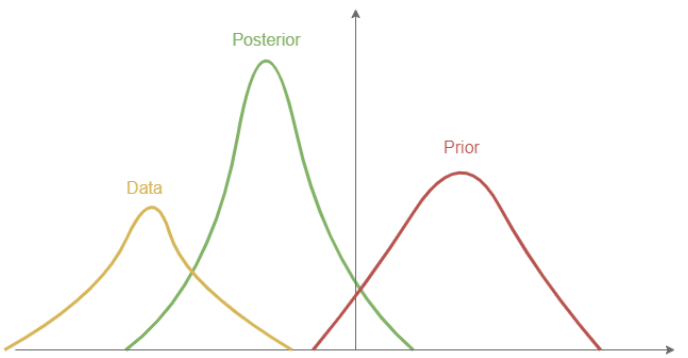
Figure 6. Representation of a Bayesian probabilistic model.